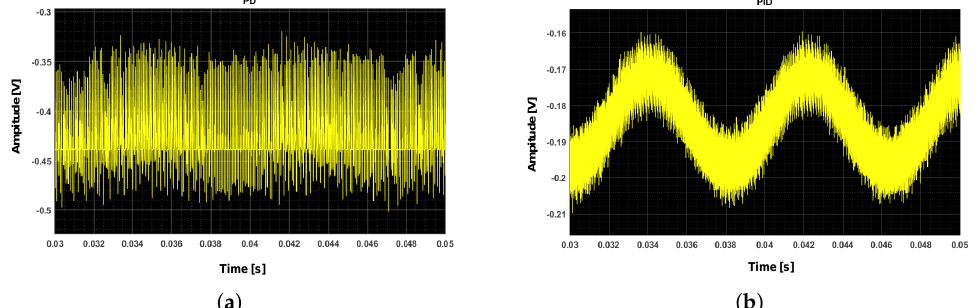
Figure 8. The waveform in front of electrical Σ∆ modulator: ( a ) with a traditional phase lead compensator; ( b ) with the proposed PID (proportional integral differential)